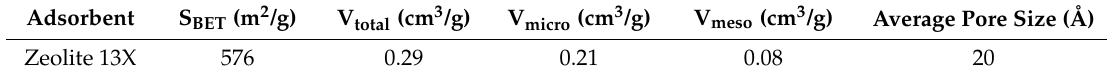
Table 1. Textural characterization for the zeolite 13X, performed by adsorption of N 2 at 77 K using a Micromeritics ASAP 2010 apparatus.